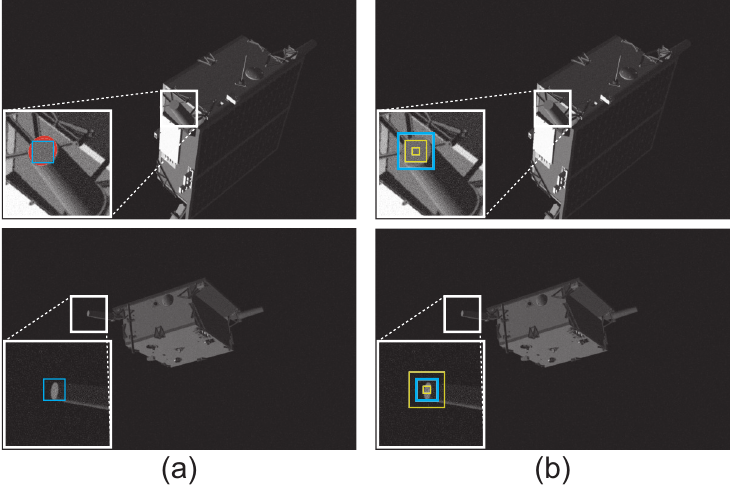
Figure 1. Our advantage over Chen [19] on how to set the region of keypoints. ( a ) Chen [19], ( b ) Ours. The blue box represents the box containing a keypoint, and the yellow box represents the anchor in our Keypoint Detection Network. When the relative distance of the spacecraft is too small, the fixed region ignores some key area of the keypoint. However, our adaptive region size can solve this problem better, which is described in Section